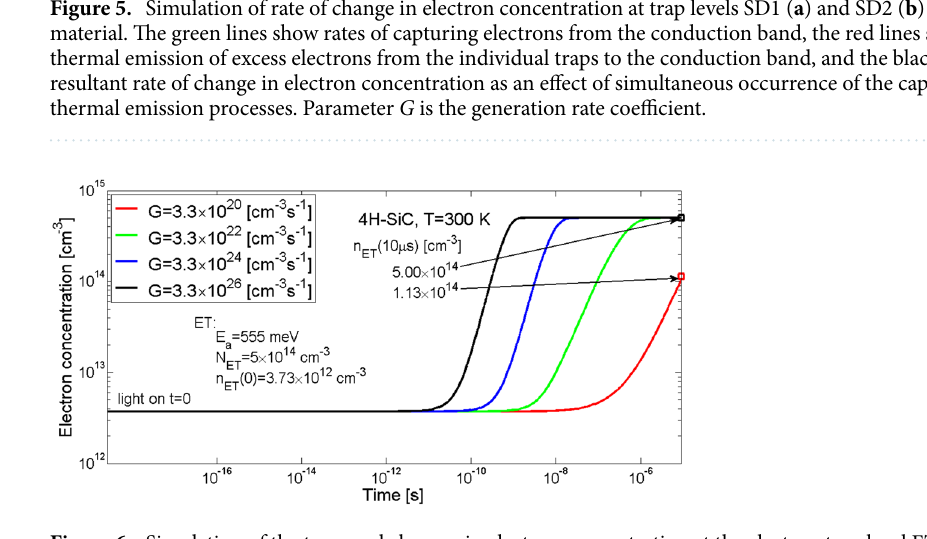
Figure 6. Simulation of the temporal changes in electron concentration at the electron trap level ET in 4H-SiC material. Parameter G is the generation rate